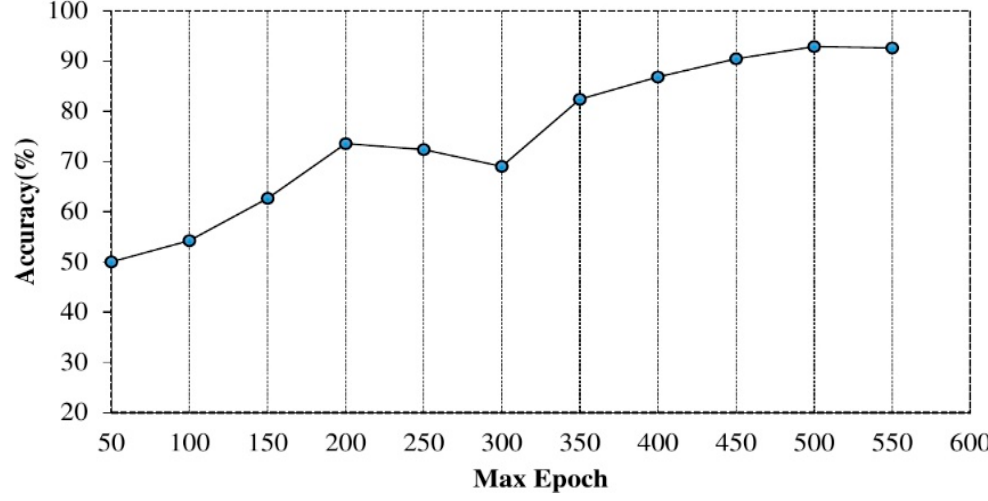
Figure 6. Max epoch Versus Accuracy.